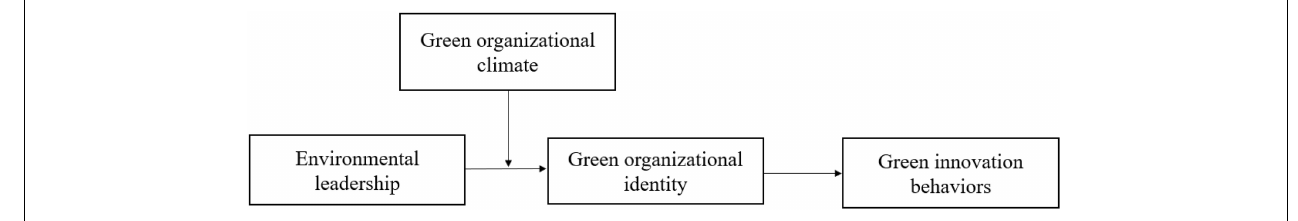
FIGURE 1 | The hypothesized